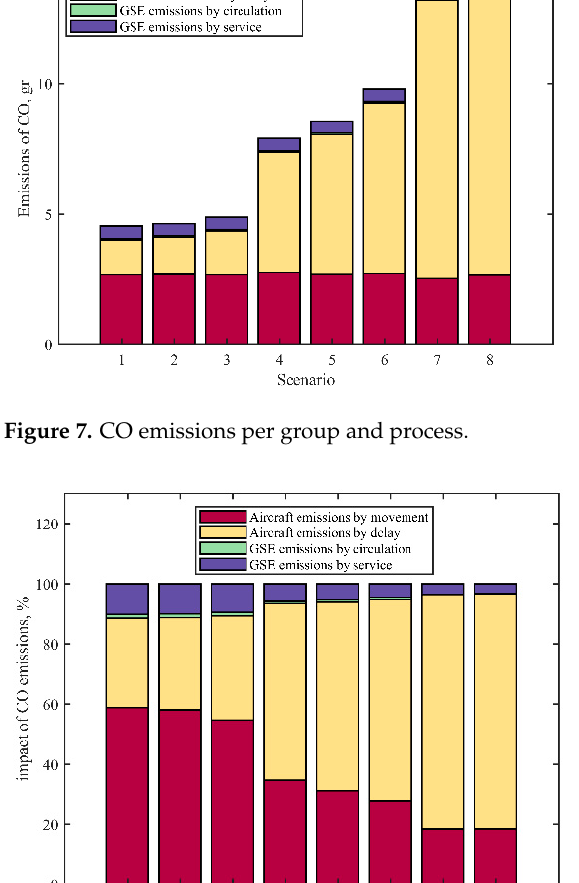
Figure 7. CO emissions per group and process.